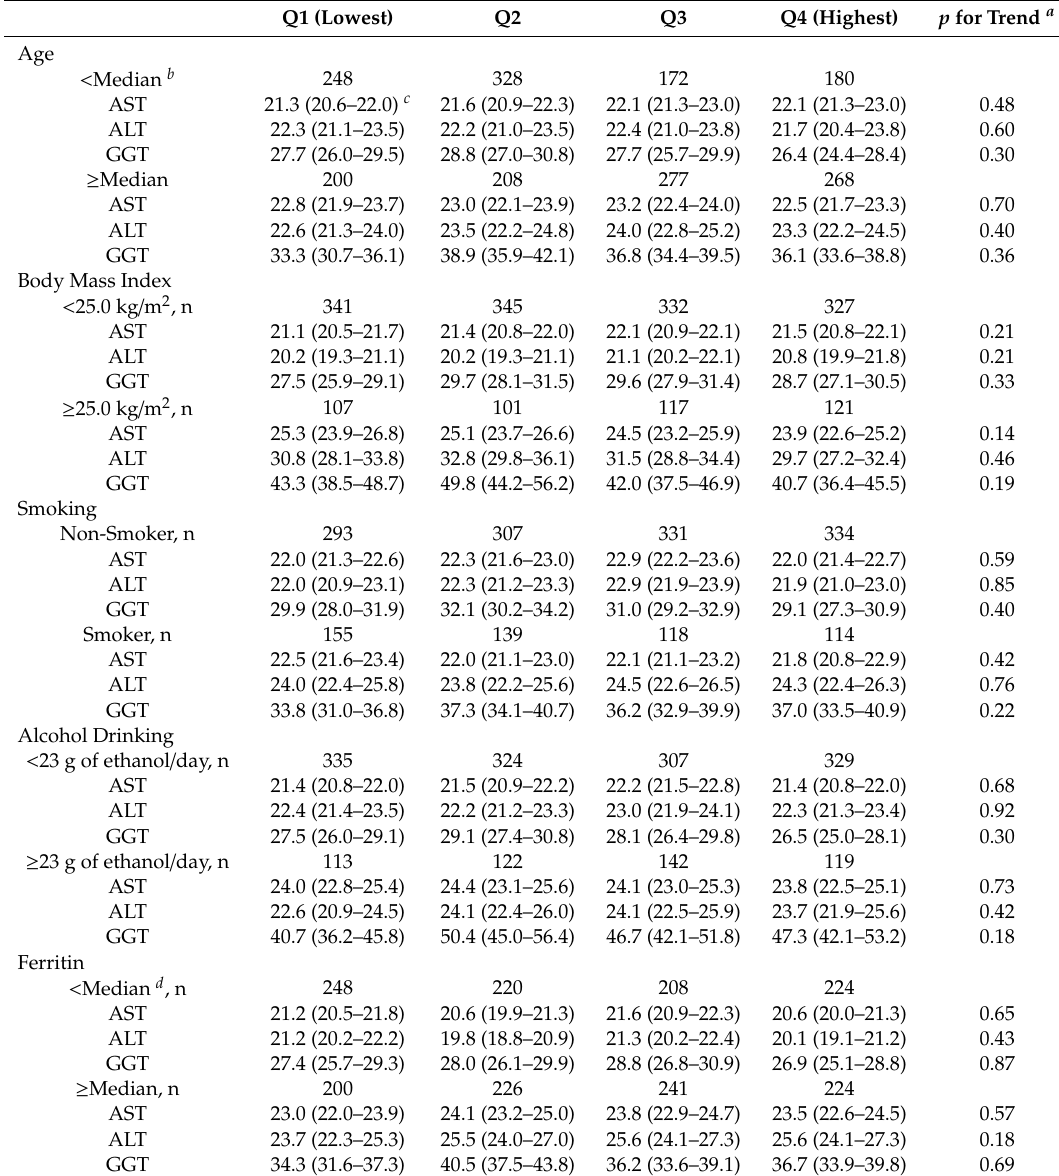
Table 4. Geometric means (95% CI) of serum liver enzyme levels according to quartiles (Q) of dietary overall NEAC estimated by FRAP, stratified risk factors of liver